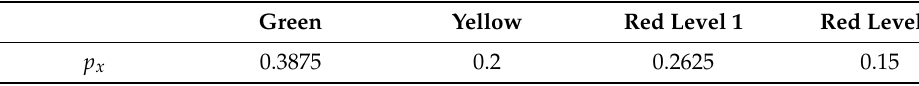
Table 9. Probability occurrence of all tariff flags.